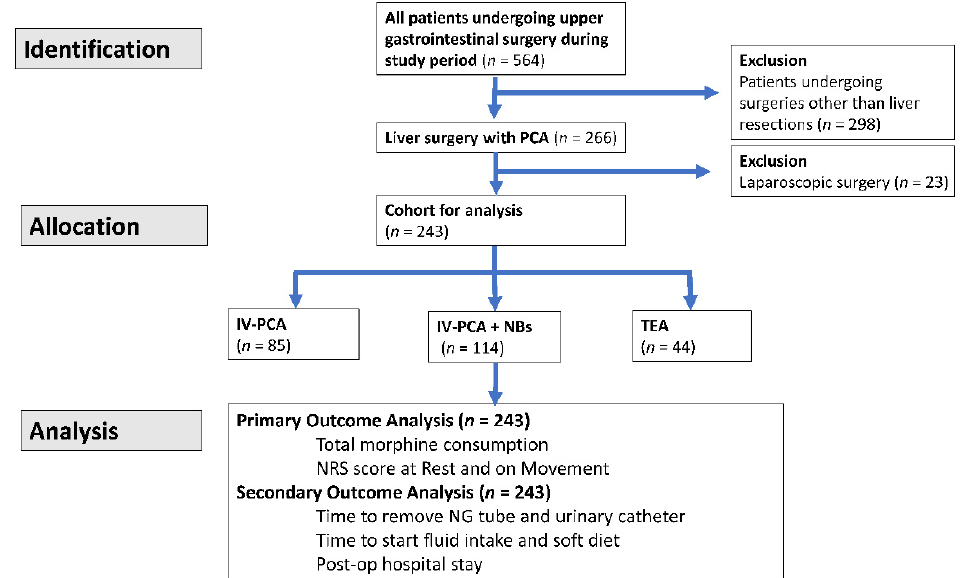
Figure 1. The flowchart of patient identification, allocation, and analysis.